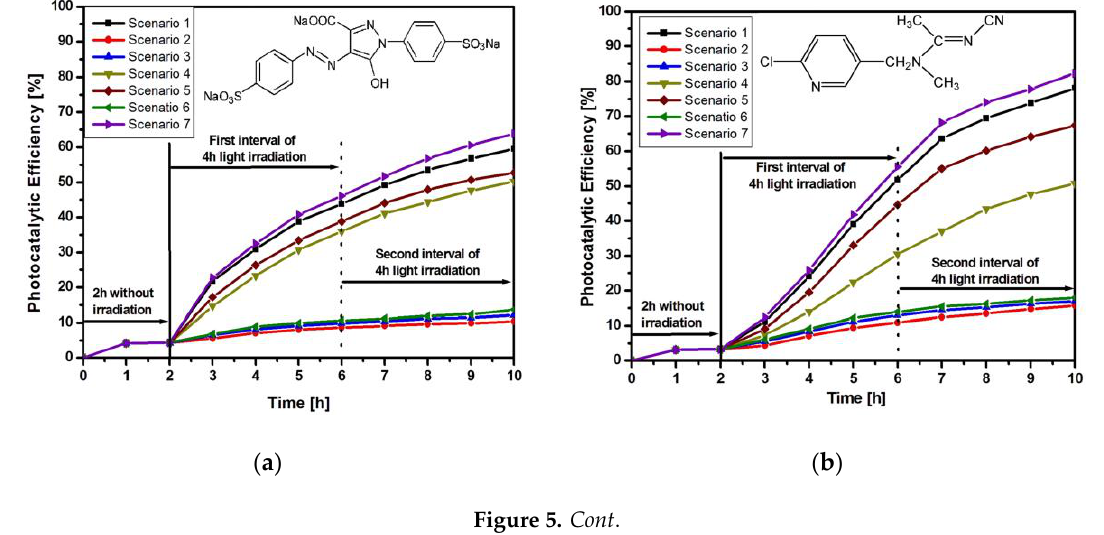
( d ) Figure 5. Photocatalytic parameters of the Ti_Al sample: ( a ) Tr photodegradation; ( b ) Apd photodegradation; ( c ) total irradiance vs. photocatalytic efficiency, and ( d ) photon flux vs. photocatalytic efficiency.